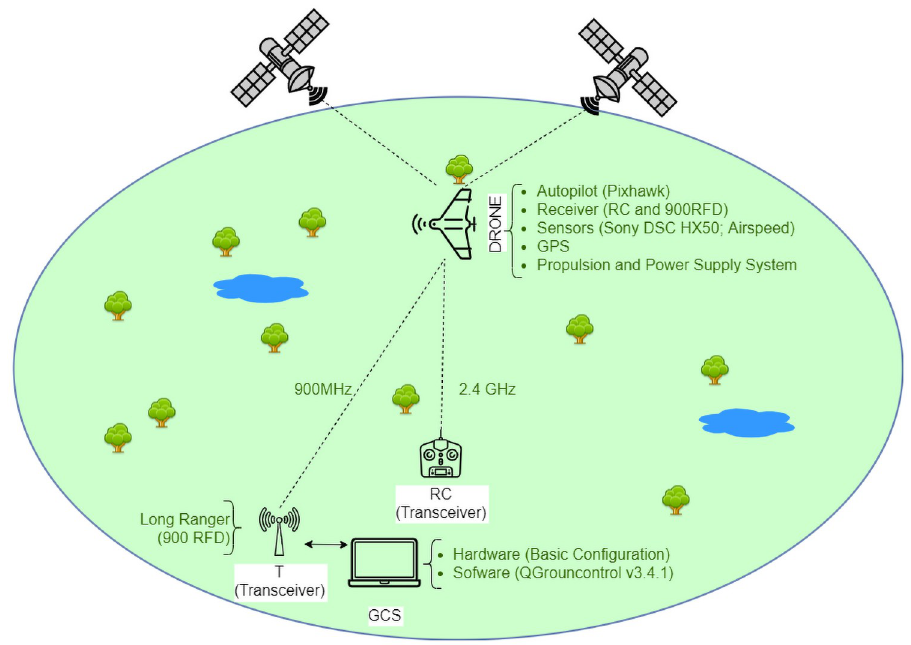
Fig 2. Schematic of the system’s four main